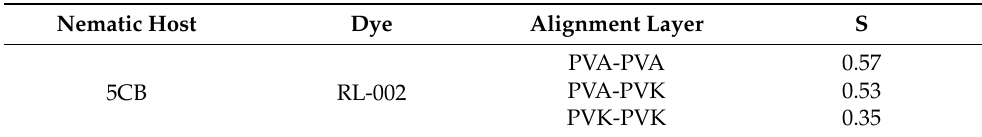
Figure 3. ( a ) Transmission spectra of the PVA–PVA cell at different applied voltages; ( b ) Transmission spectra of the PVA– PVK cell at different applied voltages; ( c ) Transmittance at 500 nm of the two cells under different applied voltages.